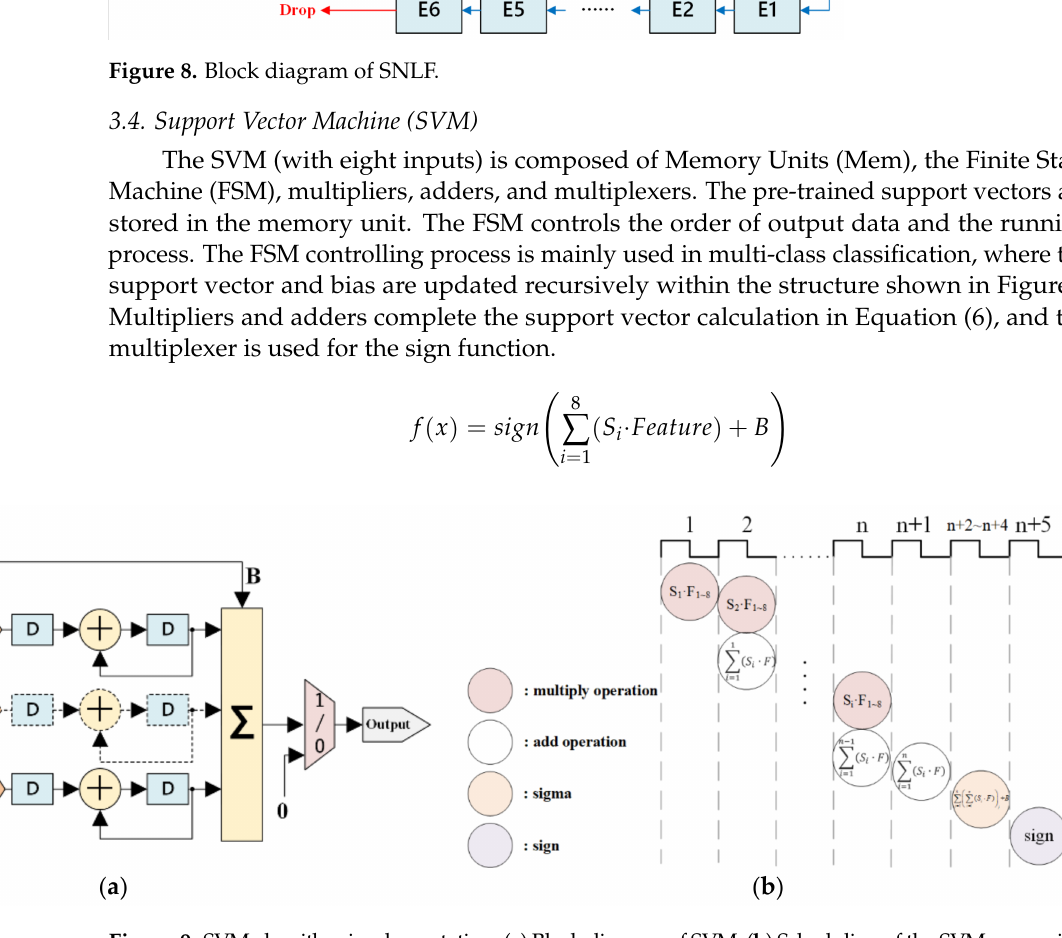
Figure 9. SVM algorithm implementation. ( a ) Block diagram of SVM. ( b ) Scheduling of the SVM